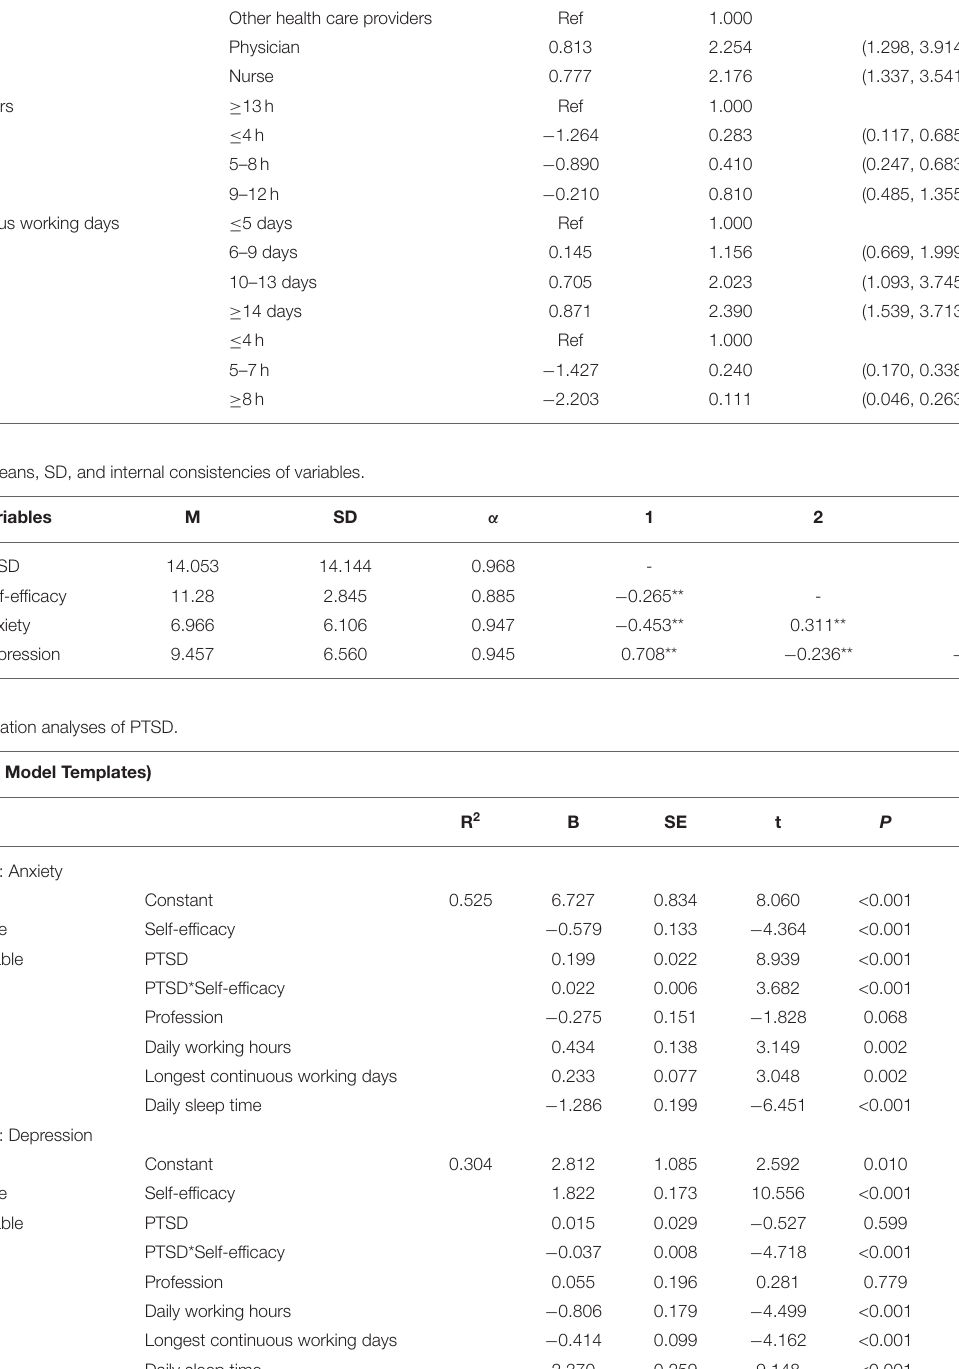
Figure 3 . The modified model and standardized path are shown in Figure 4